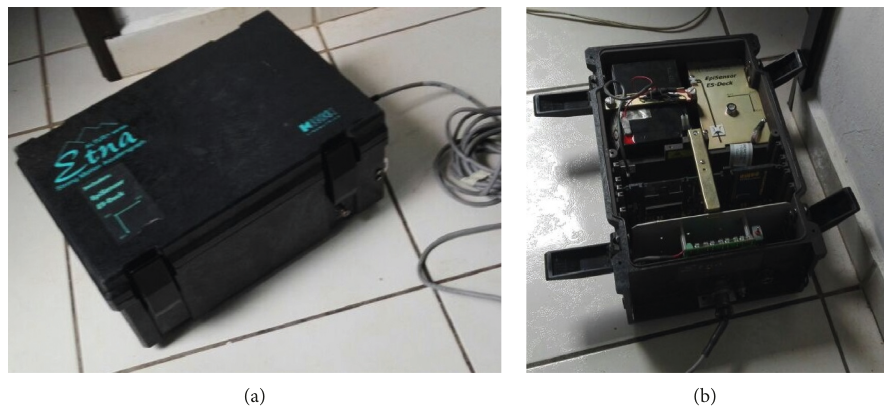
Figure 2: ETNA accelerometer: (a) outside view; (b) interior